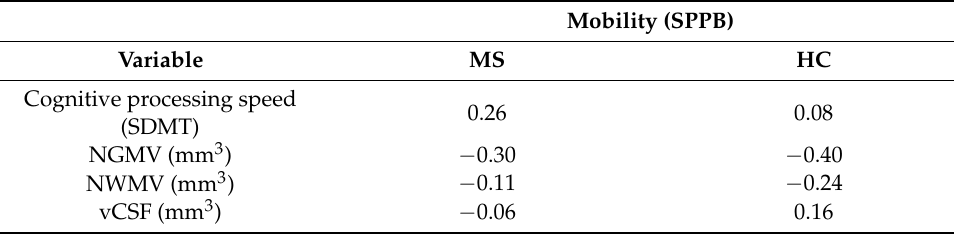
Table 3. Correlations between central factors and